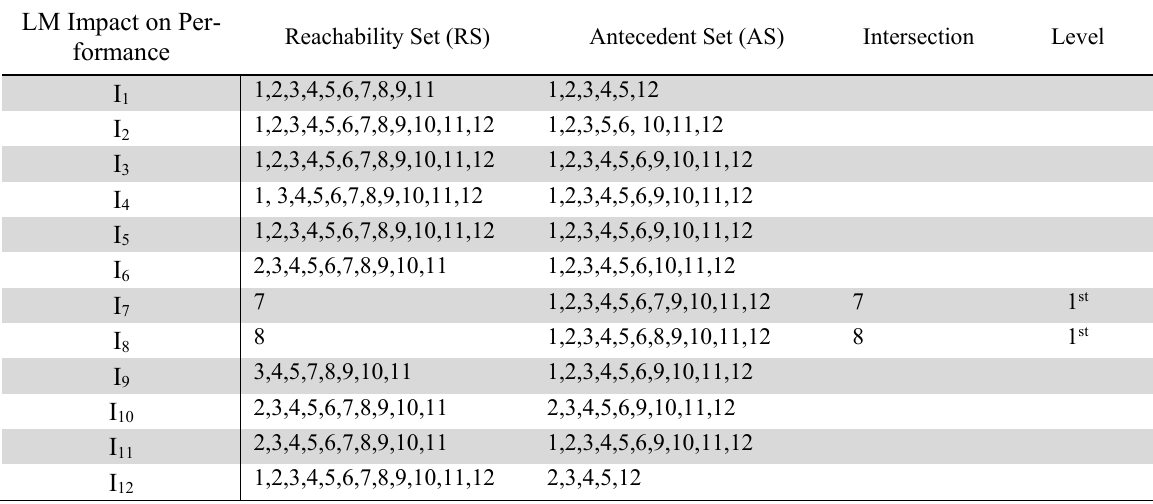
First Level Partition LM Impact on